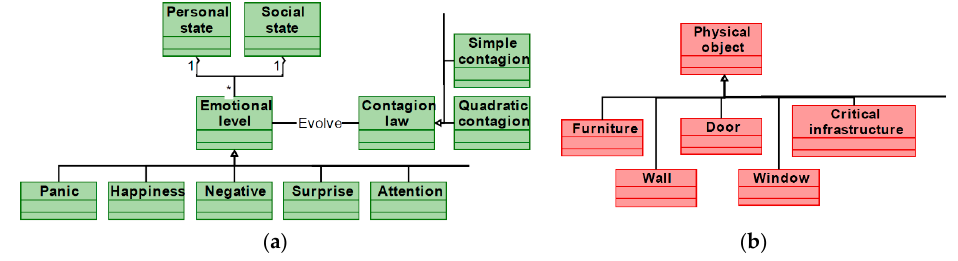
Figure 12. Extensions for the simulation model ( a ) Social world ( b ) Physical world.